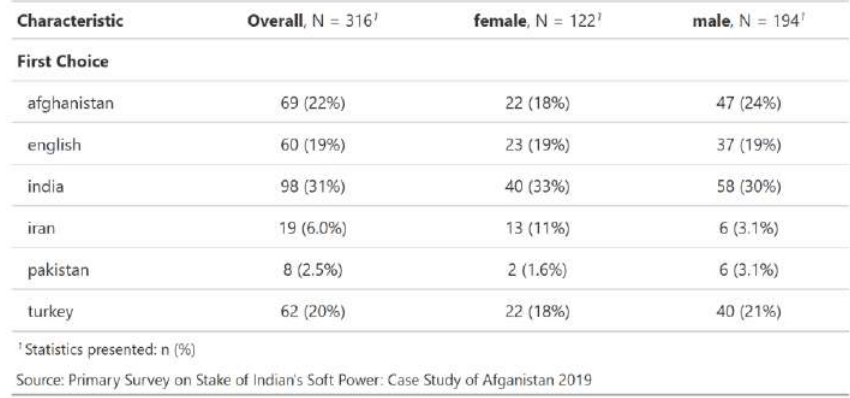
Table 13: Serials from which of the following countries/region do you prefer to watch